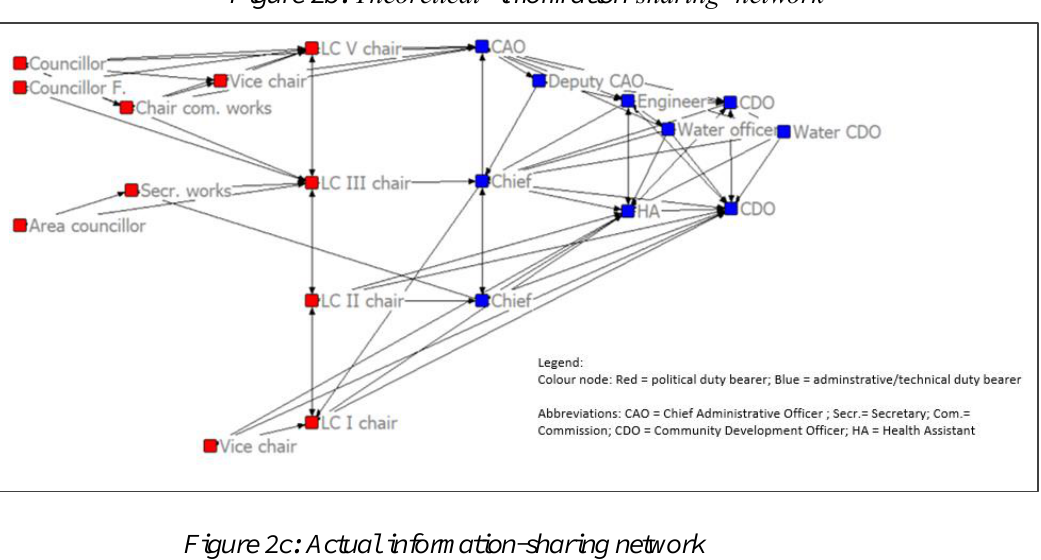
Figure 2b: Theoretical ‘information-sharing’ network